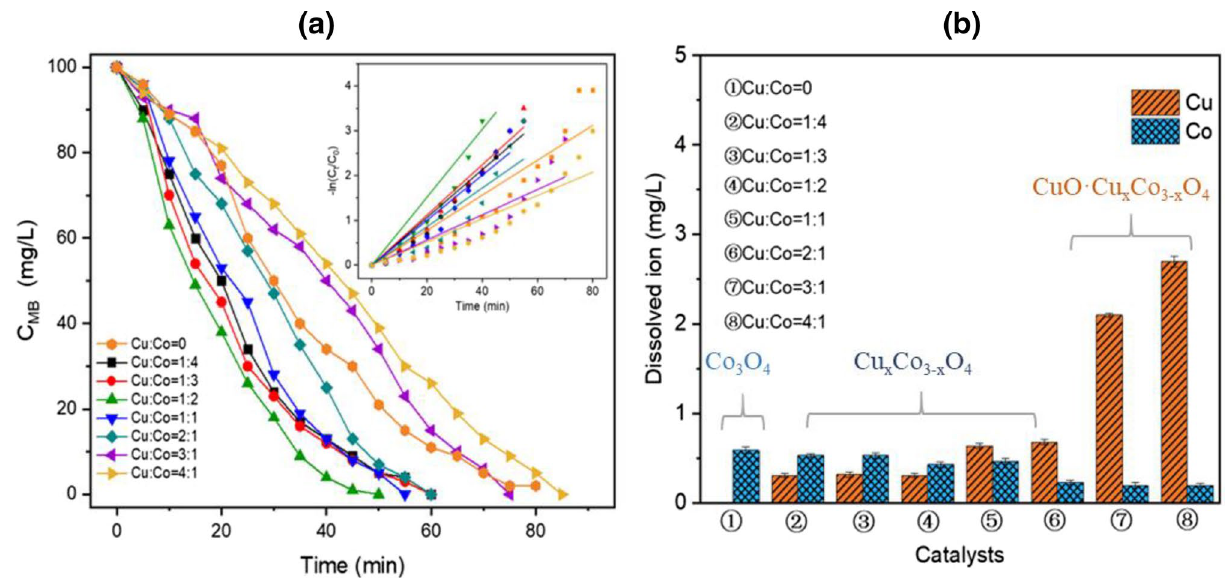
Fig. 5 Removal of methylene blue (100 mg/L) in water with Fenton-like process using various catalysts: a decolorization efficiency and b metal ion leaching (conditions: 0.6 g/L catalyst and 0.09 H 2 O 2 at pH = 6.7 and 25